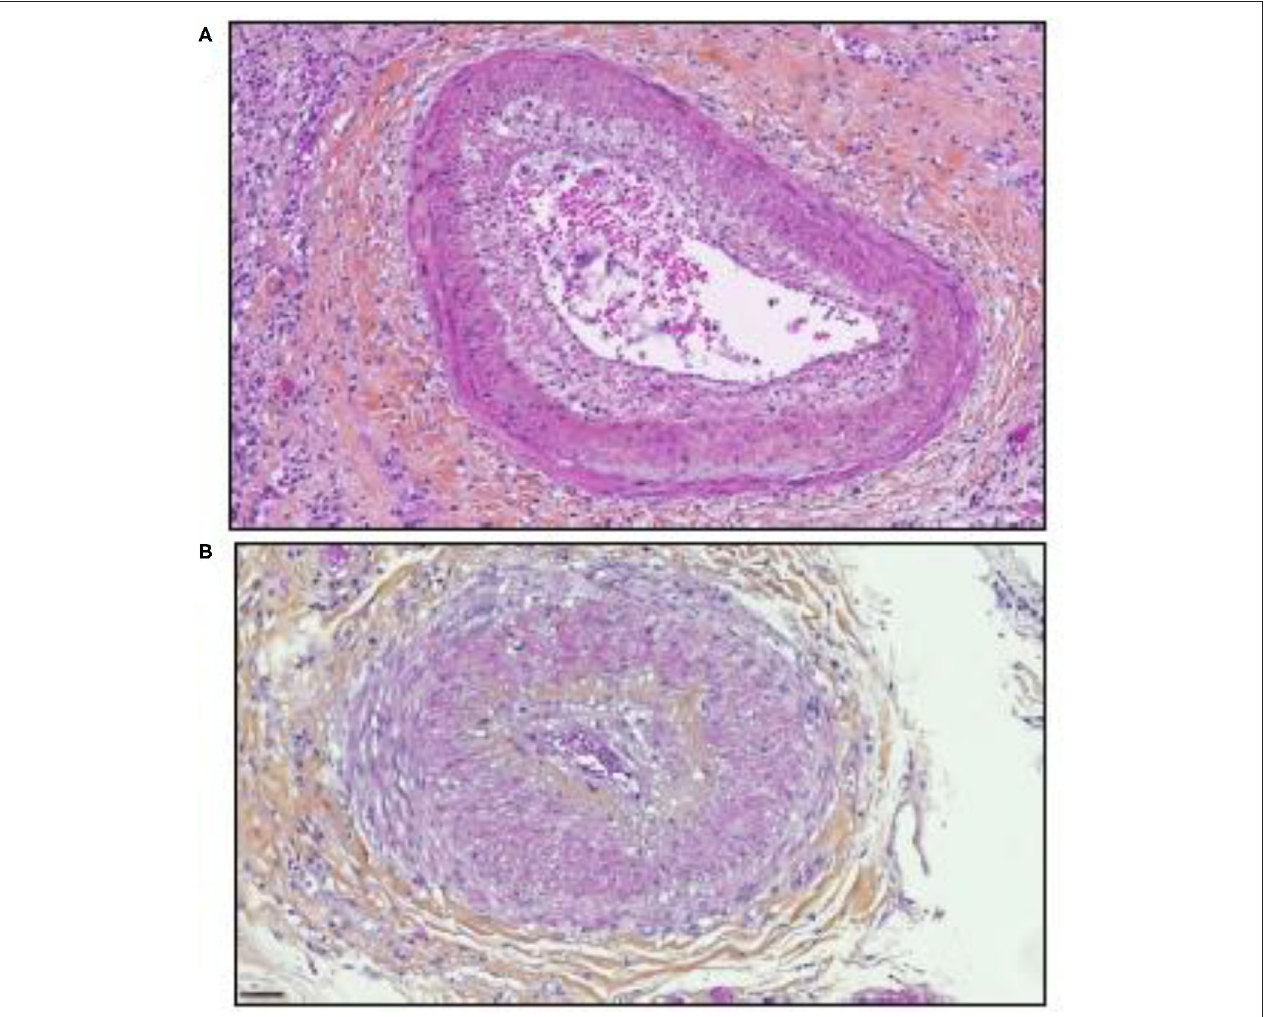
FIGURE 3 | Illustration of the microscopic examination of histological sections of tissues from patients who died of COVID-19 (postmortem formalin lung sample from medical autopsy performed in the forensic medicine department of Marseille Hospital). The histological sections were stained using hematoxylin, eosin, and saffron (hematoxylin stains the cell nuclei blue, eosin stains the extracellular matrix and cytoplasm pink, the saffron stain in orange the conjunctive matrix). (A) Vascular rejection is characterized by concentric thickened artery secondary to intimal proliferation and endovasculitis. Original magnification × 150. (B) Concentric thickened artery secondary to fibrointimal proliferation. Original magnification × 200 µ